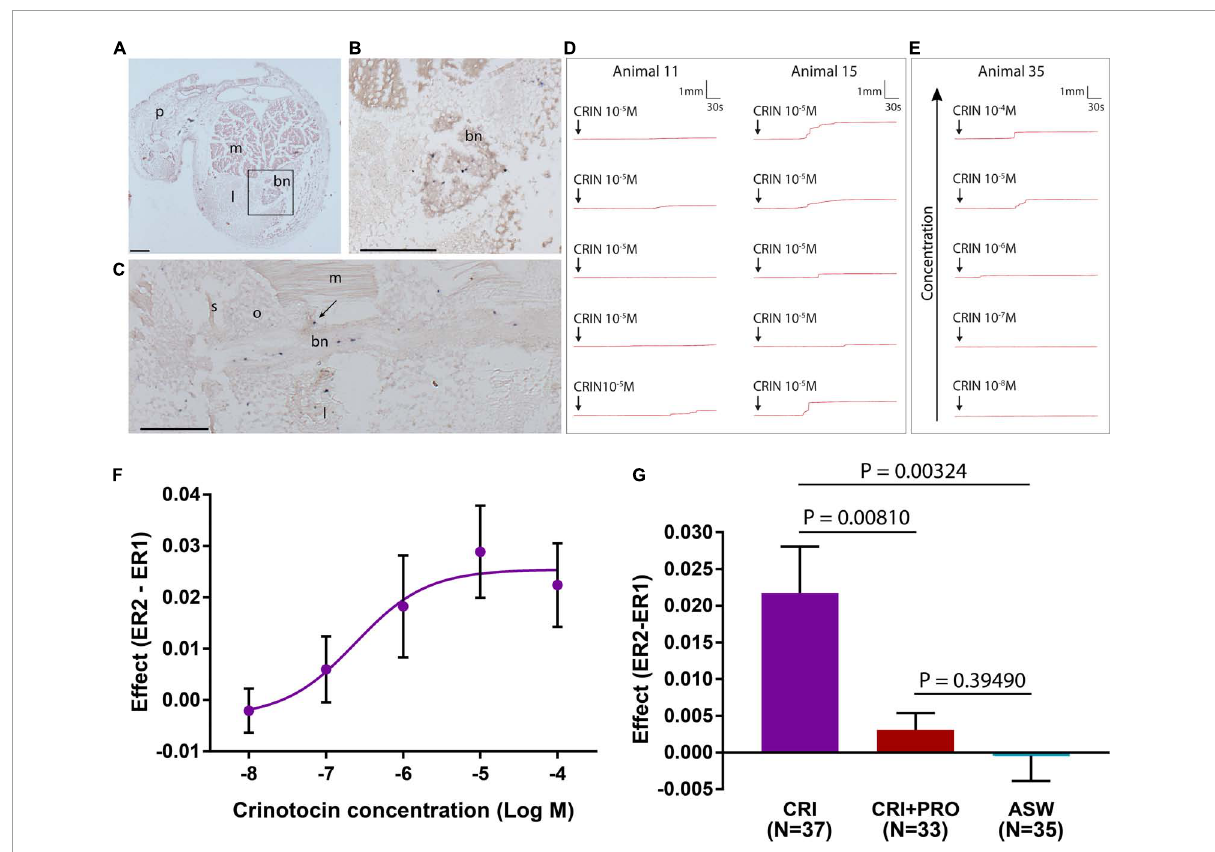
FIGURE13 Crinotocin precursor expression in Antedon mediterranea and in vitro effects of crinotocin on arm preparations. (A–C) Arm sections of A. mediterranea labeled with antisense probes for crinotocin precursor transcripts using mRNA in situ hybridization. bn, brachial nerve; l, ligament; m, muscle; p, pinnule; o, ossicle. s, syzygy; Scale bars: 120 µ m for (A,B) ; 210 µ m for (C) . (A) Transverse section of the arm, with the square showing the region containing the brachial nerve, which is shown at higher magnification in panel (B) . (B) High magnification image of the brachial nerve, showing the presence of crinotocin precursor-expressing cells in the core and margins of the nerve. (C) Sagittal section of an arm, showing labeled cells in the brachial nerve along its length and in branches of the brachial nerve that innervate ligaments and muscles (arrow). (D) Effects of crinotocin (10 − 5 M) on arm preparations, with five tests on different preparations from two representative animals shown. After addition of crinotocin (arrow), recording was continued for several minutes. Variability in responses both within and between animals is observed. For example, with animal 11 crinotocin caused a gradual and small flexion in some arm preparations, whereas in most animals (e.g., animal 15) crinotocin caused an abrupt and large flexion in most arm preparations. (E) Concentration-dependent effect of crinotocin on